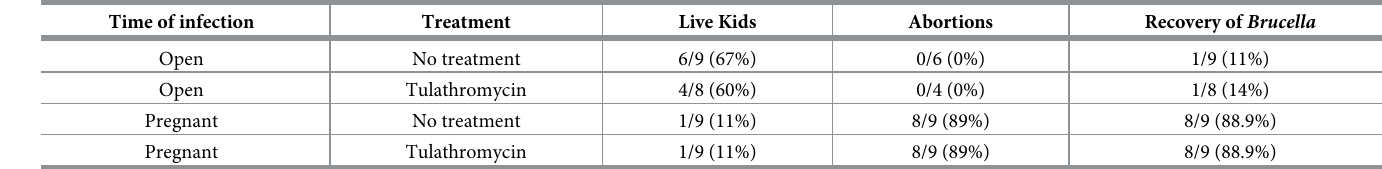
Table 3. Pregnancy detection and pregnancy rate in goats infected while open and either Tulathromycin-treated or non-treated.